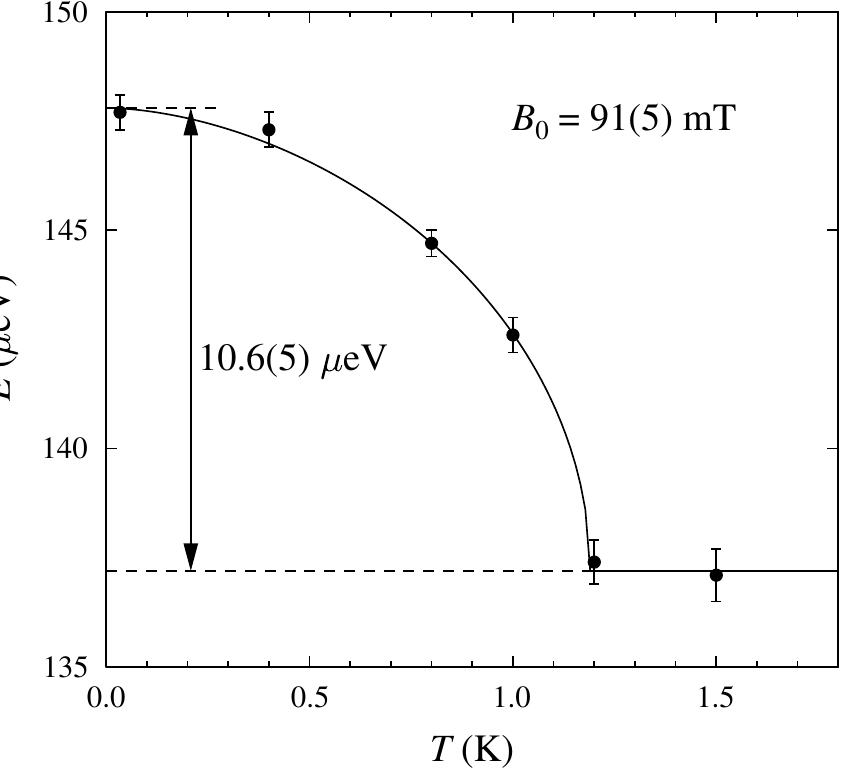
Figure 3. Temperature dependence of the lowest energy excitation of the S = 35/2 ground state (from S z = 35/2 to S z = 33/2). The measurements were made on the LET instrument with an incident energy of 1.06 meV, and the line is a guide to the eye. The internal field in the ordered state splits the levels and shifts the transition energy. The maximum value of the internal field B 0 was determined to be 91(5)